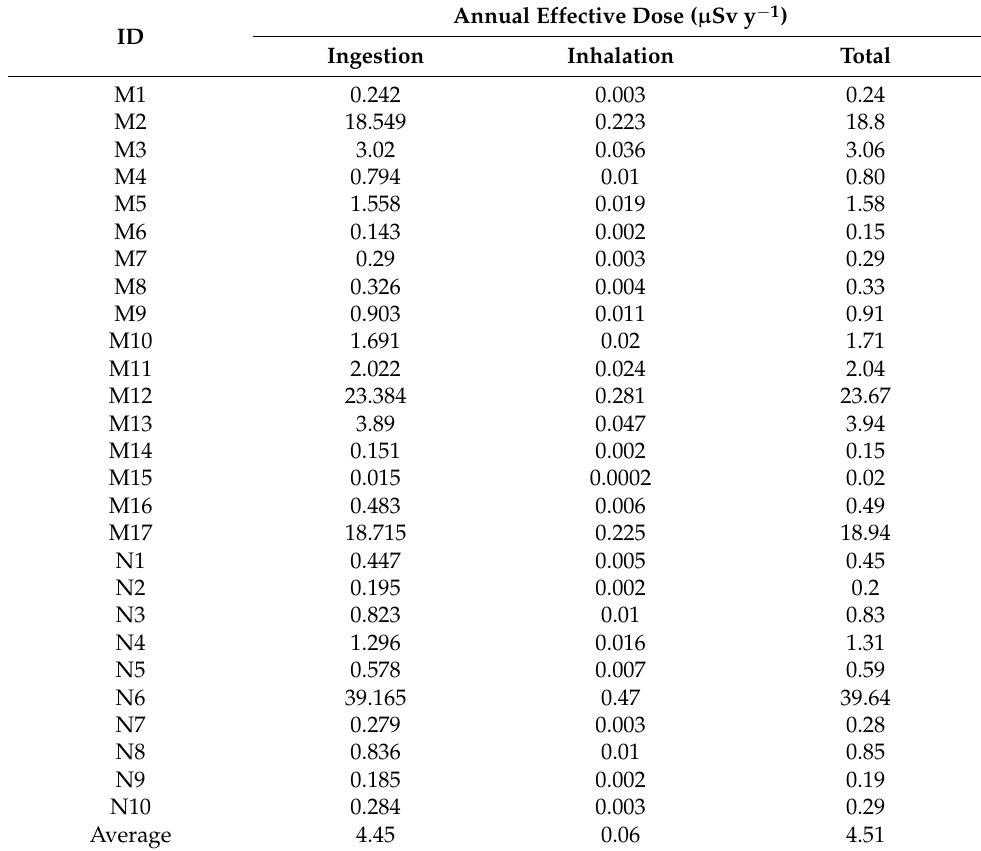
Table 3. The annual effective doses, due to inhalation and ingestion, from the consumption of drinking water. ID Ingestion